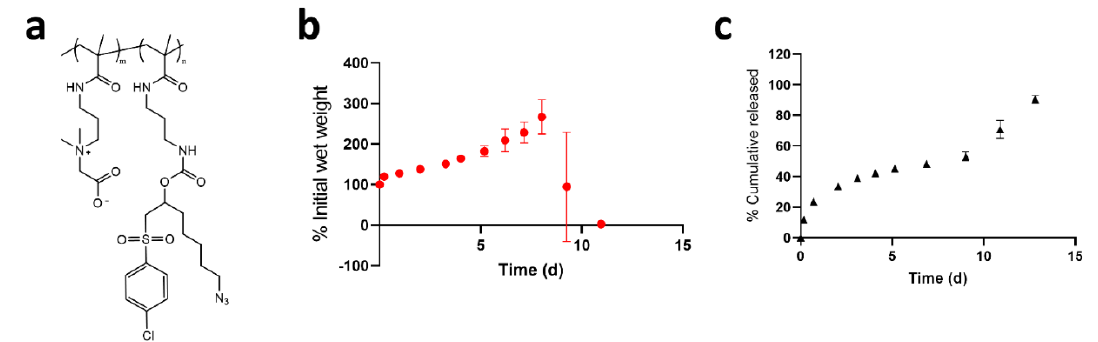
Figure 6. Release of Ab(D 30 T 70 ) from degradable pCB hydrogels. ( a ) Structure of pCB-AzCl copolymer with hydrolytic carbamate bond for hydrolysis of hydrogel crosslinks. ( b ) Degradation of pCB hydrogels over time by following the wet weight of hydrogels gelled in microcentrifuge tubes. ( c ) Complete and sustained release of Ab(D 30 T 70 ) from degradable pCB hydrogels where release is governed by the hydrogel promoted aggregation of Ab(D 30 T 70 ) and hydrogel degradation ( n = 3, ± standard deviation).